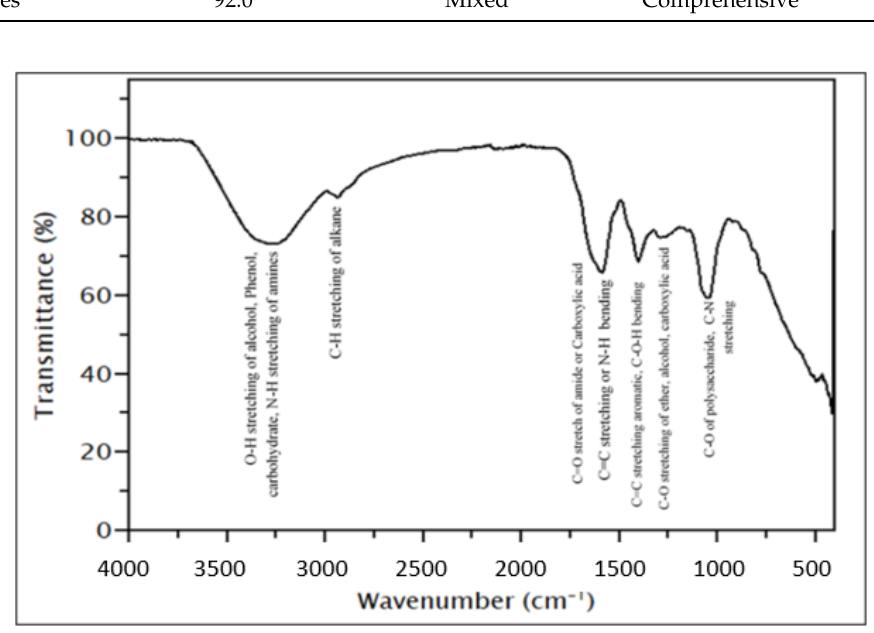
Figure 13. FTIR analysis for the detection of functional groups. Reprinted from [91].